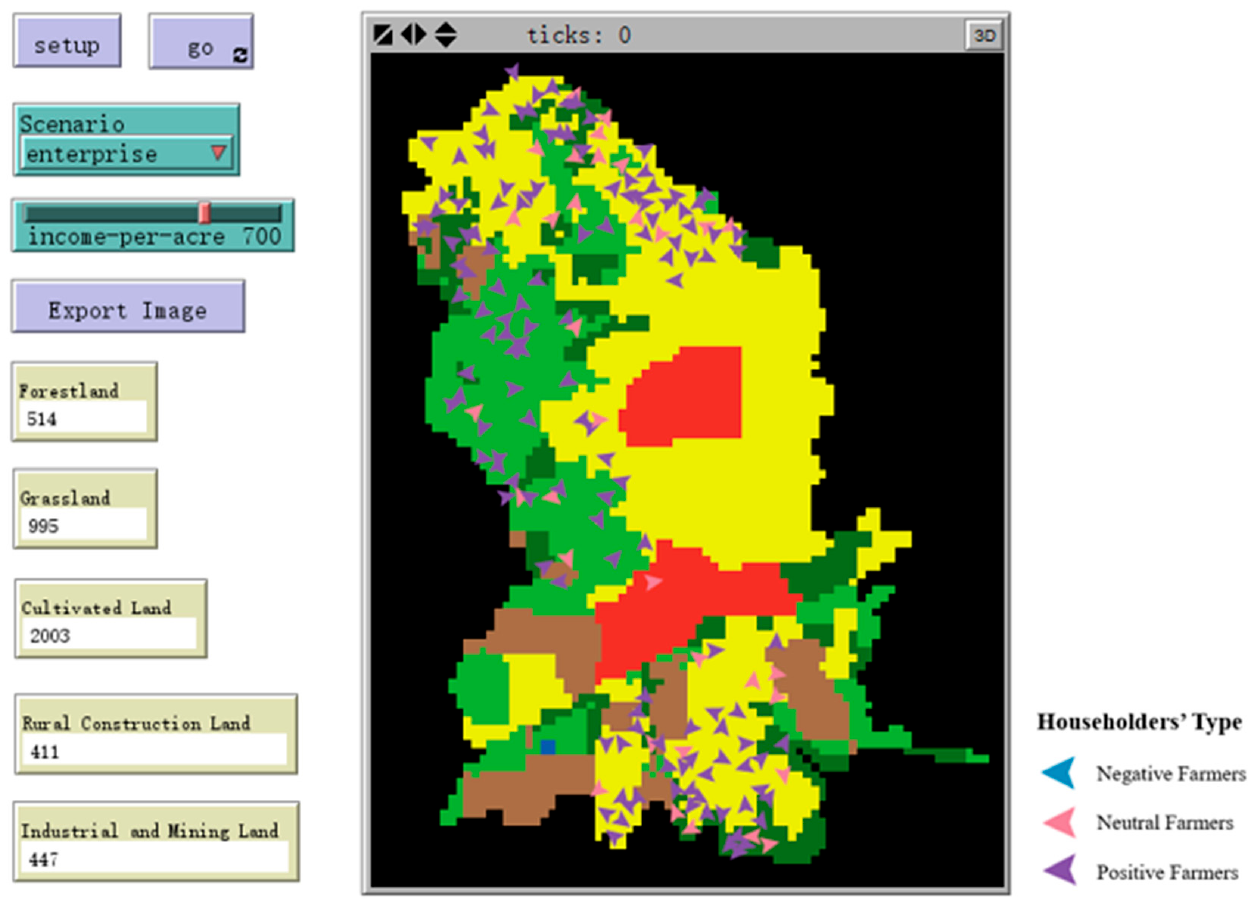
Figure 4. The simulation process of the model in Netlogo software(5.3.1).